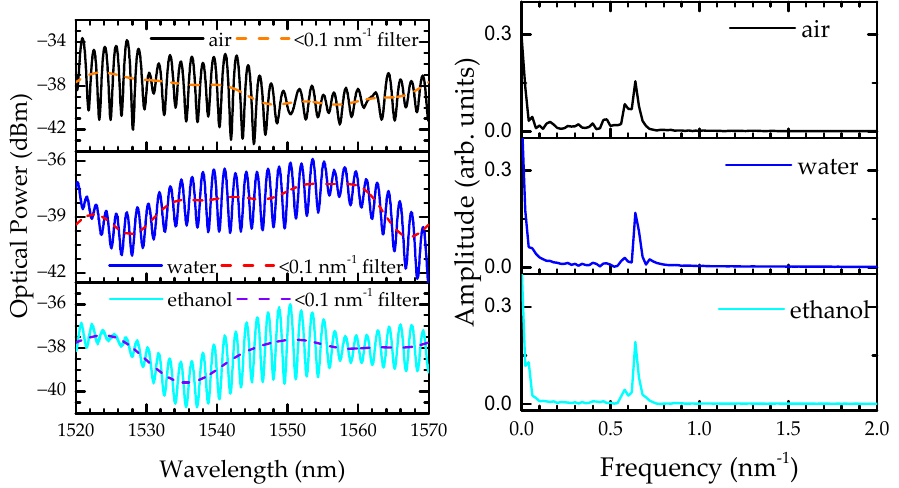
Figure 4. ( left ) Transmission spectra of the 3 mm long sensor when surrounded by air, water, and ethanol. The dashed lines represent the lowpass filter used to monitor the CMI. ( right ) Respective FFT graphs of the sensor when surrounded by air, water, and ethanol.